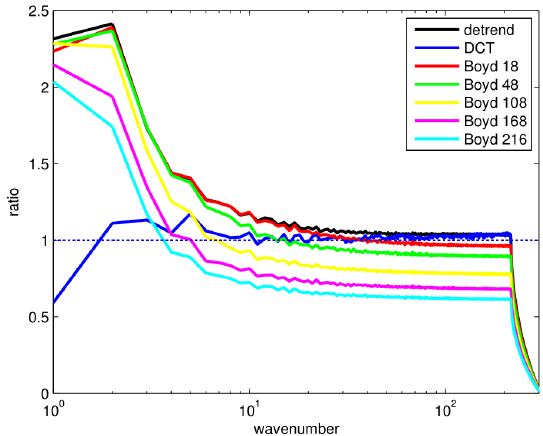
Figure 7. The ratio between the computed spectrum and the pre- scribed k ∗− 5 / 3 spectrum for the detrending method, the discrete cosine transform and the Boyd method for several widths of the ex- tension zone.